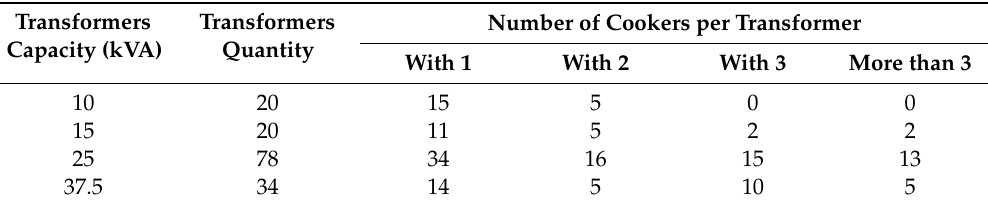
Table 4. Transformers sample with induction cookers.